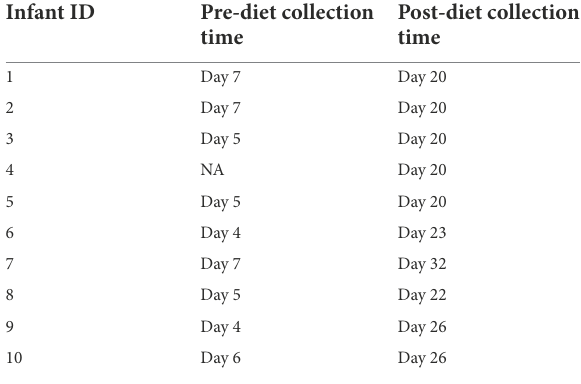
TABLE 2 Infant stool sample collection times across the study.